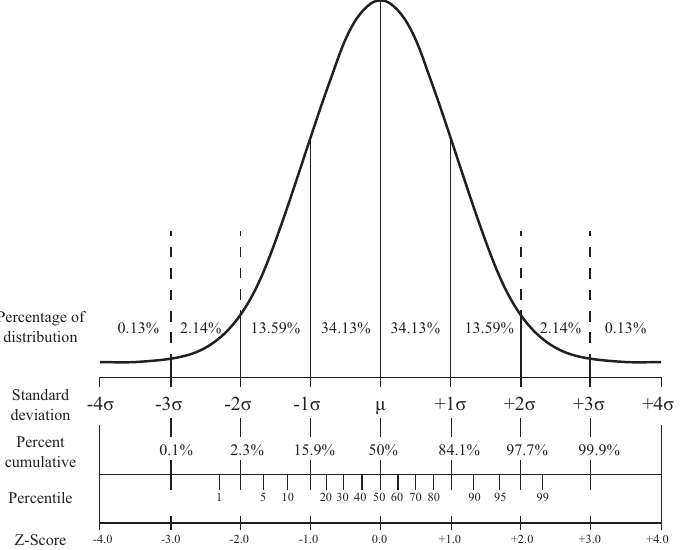
Figure 13. Area fractions (quantiles) for a normal distribution. Source: cf. [78]. The overview based on the AIC and BIC values shows that the normal function does not fit the fatigue test data of Setup I and II significantly better or worse than the other distribution models. The corresponding plots of the value curves are shown in the Appendix A—Additional plots (Figures A1 and A2). AIC: In Setup I , the first deviations appear sporadically only after 6000 cycles (60 samples). Only at the end of the tests, from 10,000 cycles, the deviations become larger and more frequent, which is due to the decreasing sample size. Setup II , on the other hand, has slight deviations over most of the test time. Only after 25,000 cycles do the deviations increase strongly, again due to the decreasing sample size. BIC: For both setups, there are hardly any deviations over the entire test